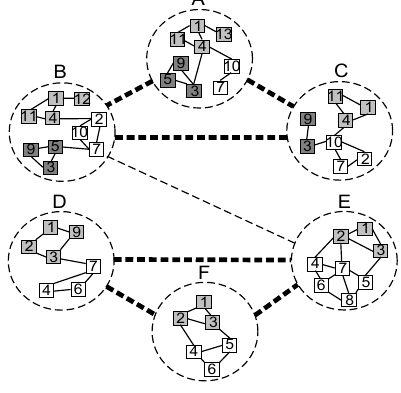
Fig. 8 Network of networks [72]